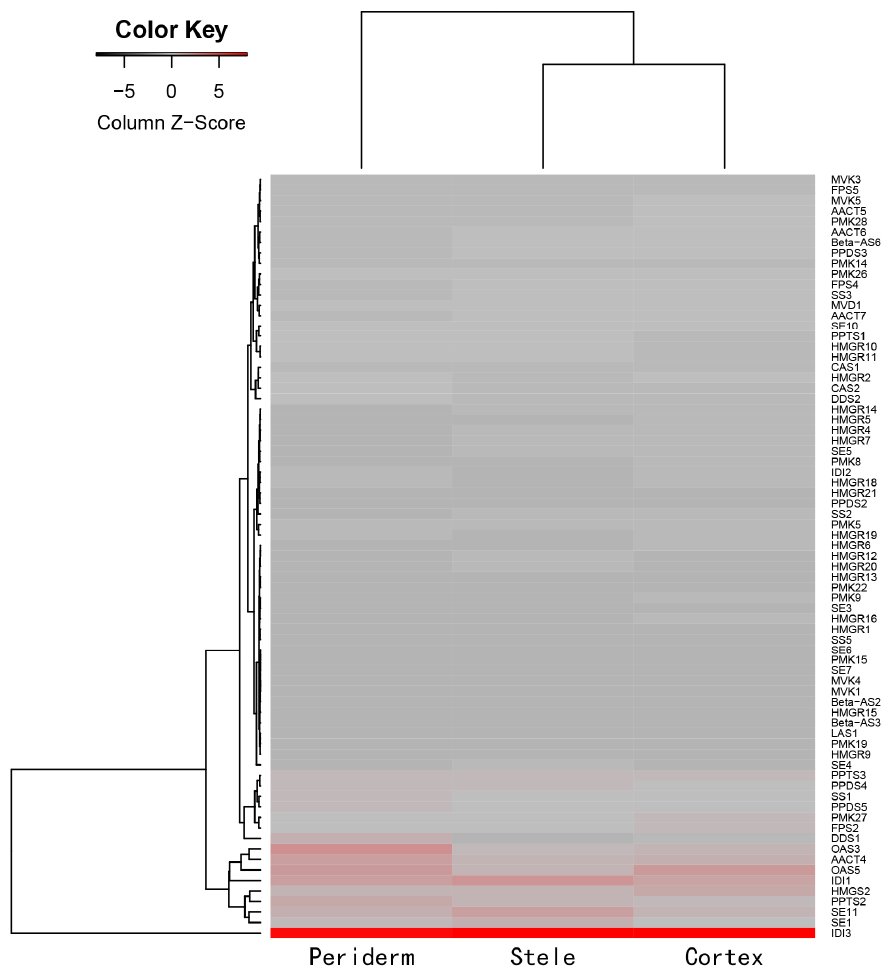
Figure 4. Heatmap of 73 MVA pathway and downstream genes involved in ginsenoside biosynthesis in ginseng main root tissues, this was constructed using an average FPKM value of five duplicates (FPKM ≥ 2).